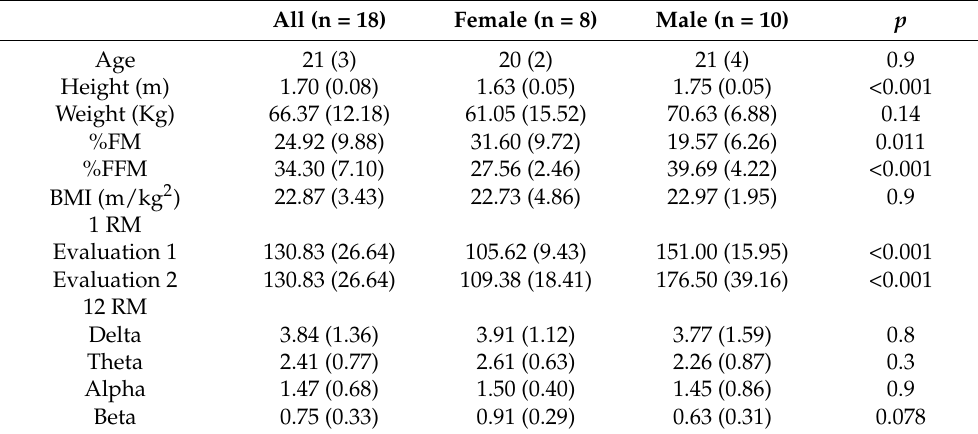
Table 1. Means (SD) of age, body composition, repetition maximum, and 12 repetition maximum assessed at moment 1 and moment